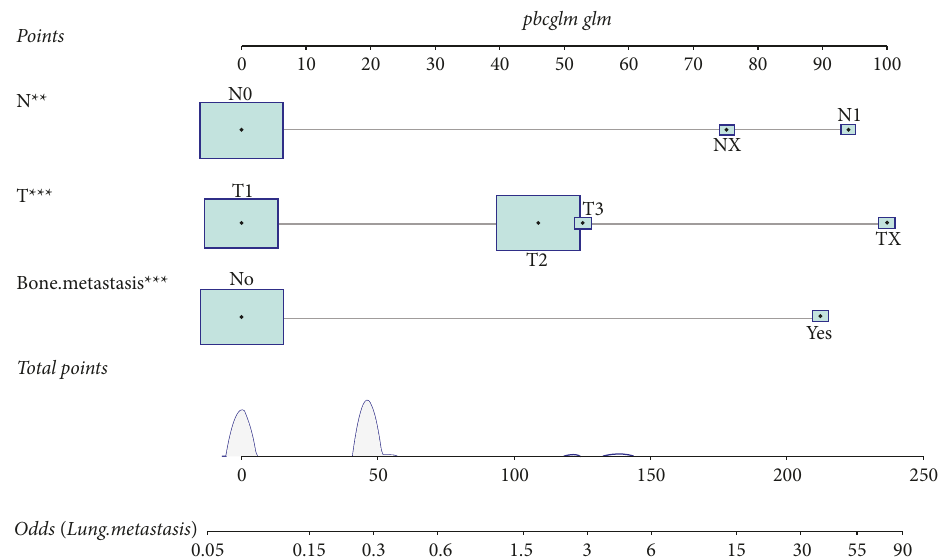
Figure 1: The nomogram incorporating three clinical variables for predicting the risk of LM in young osteosarcoma